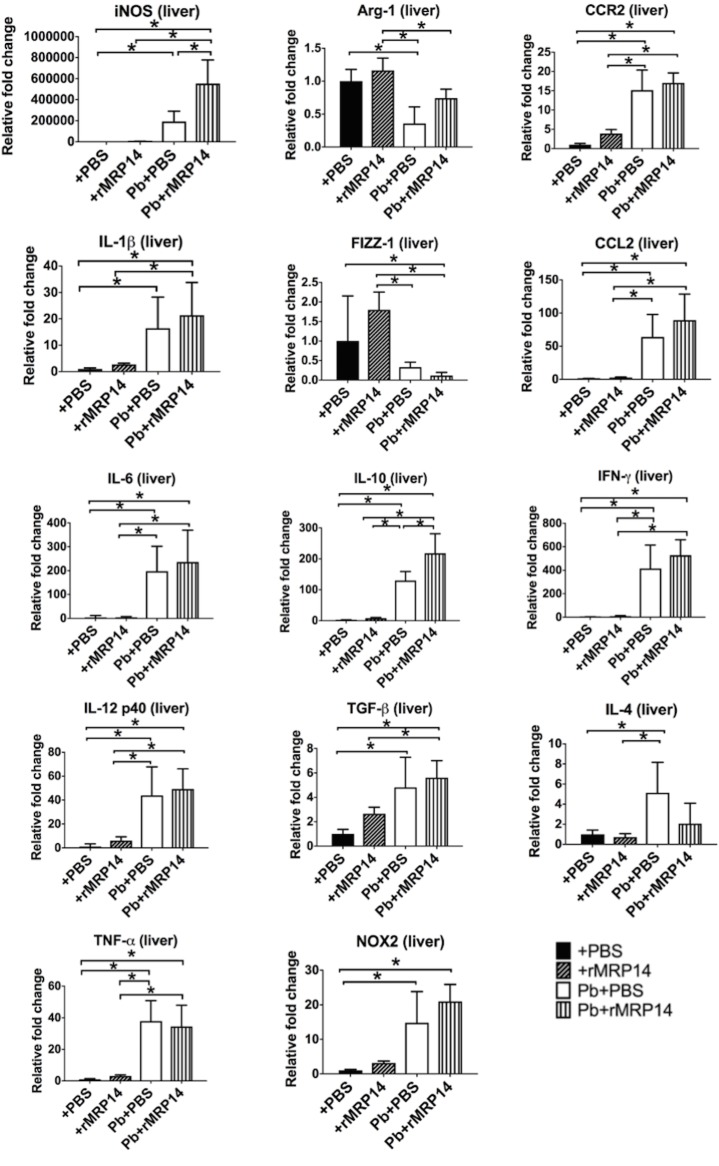
The expression of iNOS and pro-inflammatory molecules in the liver promoted by rMRP14 during rodent malaria.mRNA expression of iNOS, IL-1β, IL-6, IL-12 p40, TNF-α, Arg-1, FIZZ-1, IL-10, TGF-β, NOX2, CCR2, CCL2, IFN-γ and IL-4 in the liver of mice injected with rMRP14 or PBS after Pb-infection (n = 5). Graphs show mean and SD of each group. Data are representative of two independent experiments. *P < 0.05; n.s., not significant.